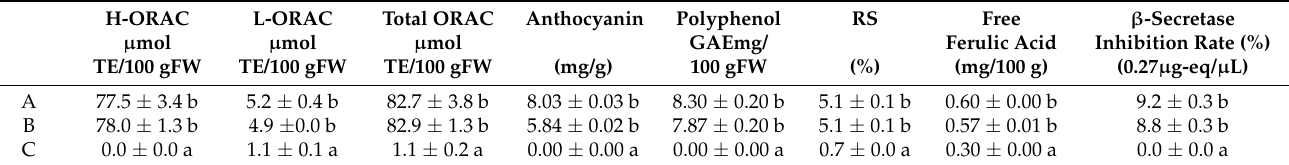
Table 4. Biofunctional properties of three kinds of cooked rice for human